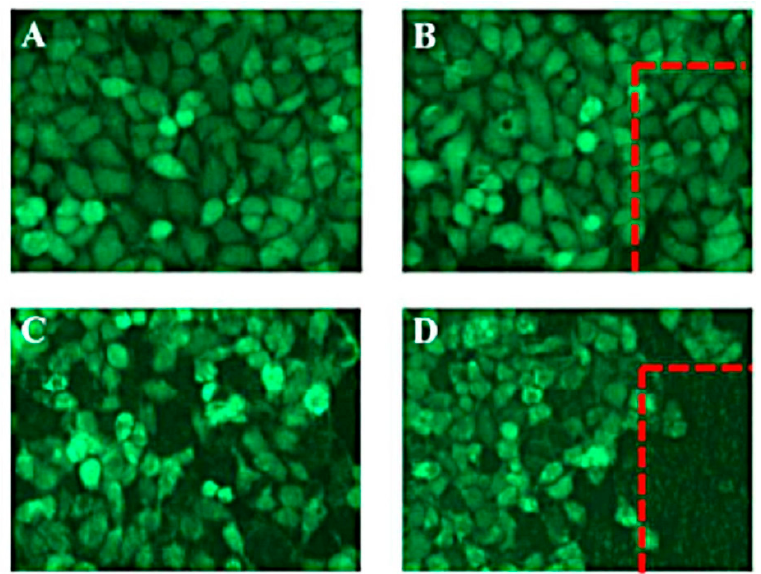
Figure 1. Images of fluorescence microscope of HeLa cells: ( A ) control; ( B ) cells subjected to laser irradiation only; ( C ) cells subjected to resveratrol loaded nanohybrid system with no irradiation; and ( D ) cells subjected to resveratrol-loaded nanohybrid with laser irradiation. This image was reproduced with permission from [53]. Copyright©, 2017, Royal Society of Chemistry.